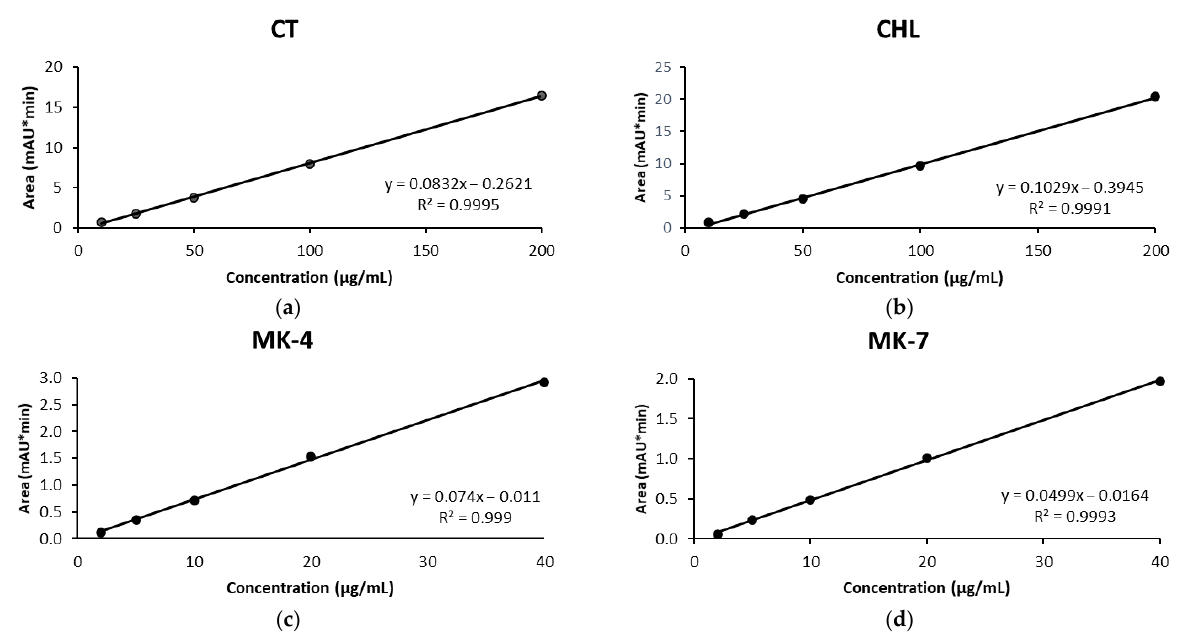
Figure 2. Calibration curves of: ( a ) calcitriol, CT, ( b ) cholecalciferol, CHL, ( c ) menaquinone, MK-4, and ( d ) menaquinone-7, MK-7.